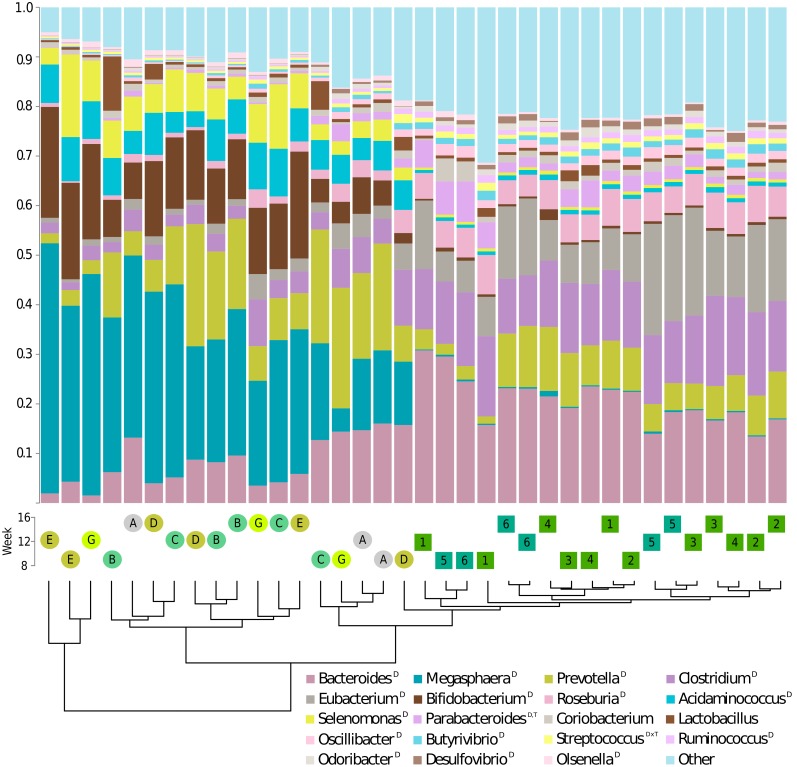
Taxonomic profiles for the 20 most abundant genera.The 19 most abundant genera were sorted from bottom to top by descending overall relative abundance in the 36 samples. The last interval summarizes all remaining genera. Hierarchical clustering of relative abundances of all genera clearly split samples by diet (see dendogram). Samples are coded by diet (rectangles/letters for high and circles/numbers for medium protein), litter (color) and week (vertical position). Superscript letters in legend indicate significant diet, time, or diet by time effects.